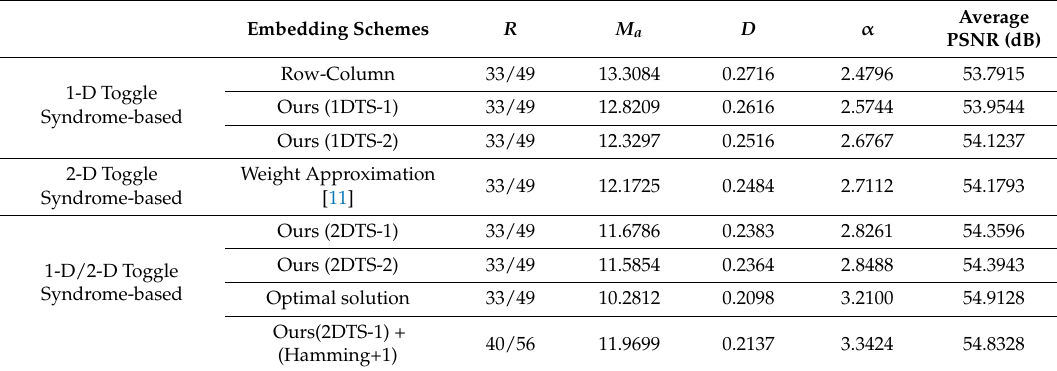
Table 5. Comparison of embedding efficiency among all schemes.